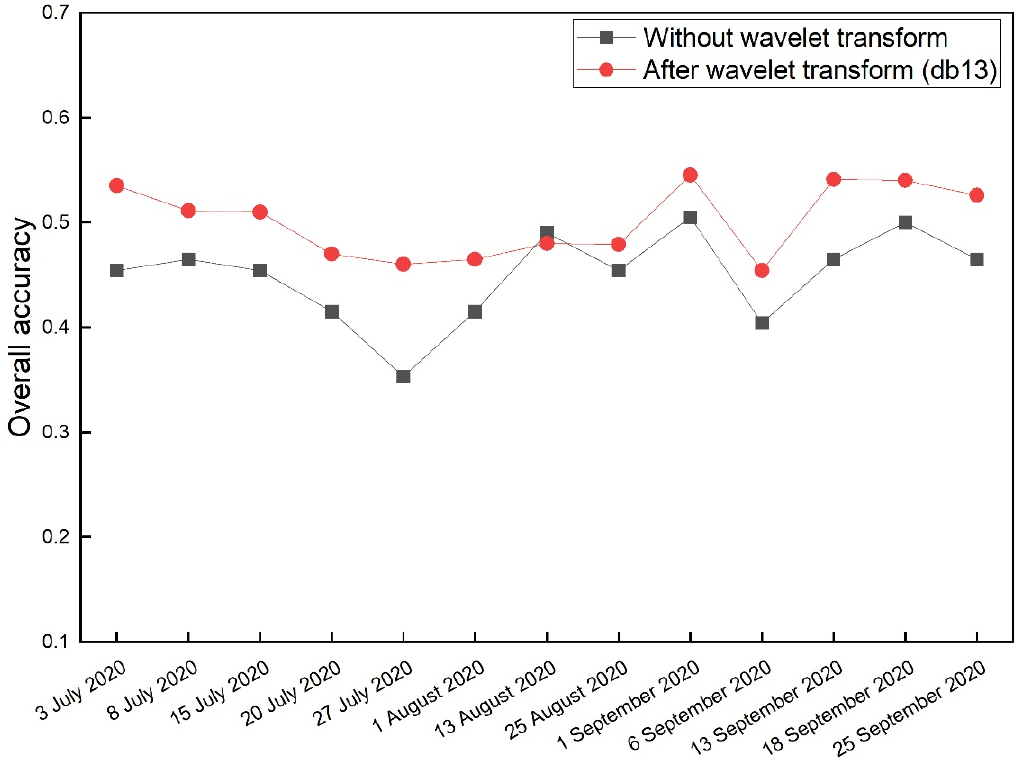
Figure 6. Robustness test results of db13. The horizontal axis represents the imaging date of SAR data, and the vertical axis represents the overall accuracy of the classification.